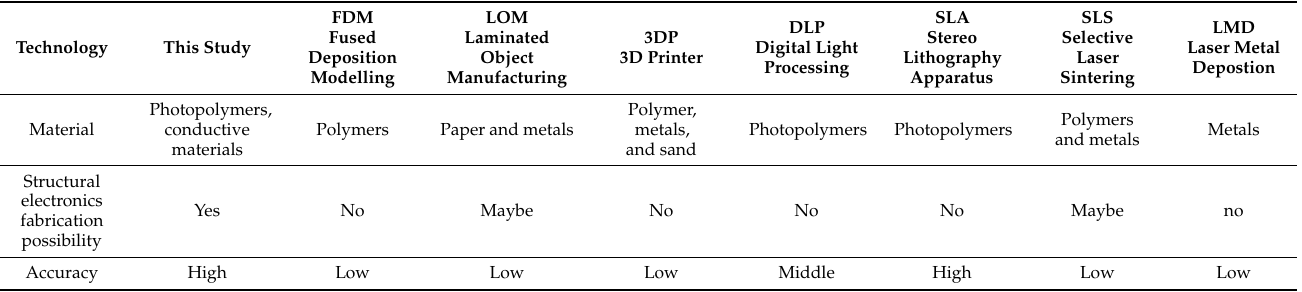
Table 1. Comparison of conventional 3D printing and this